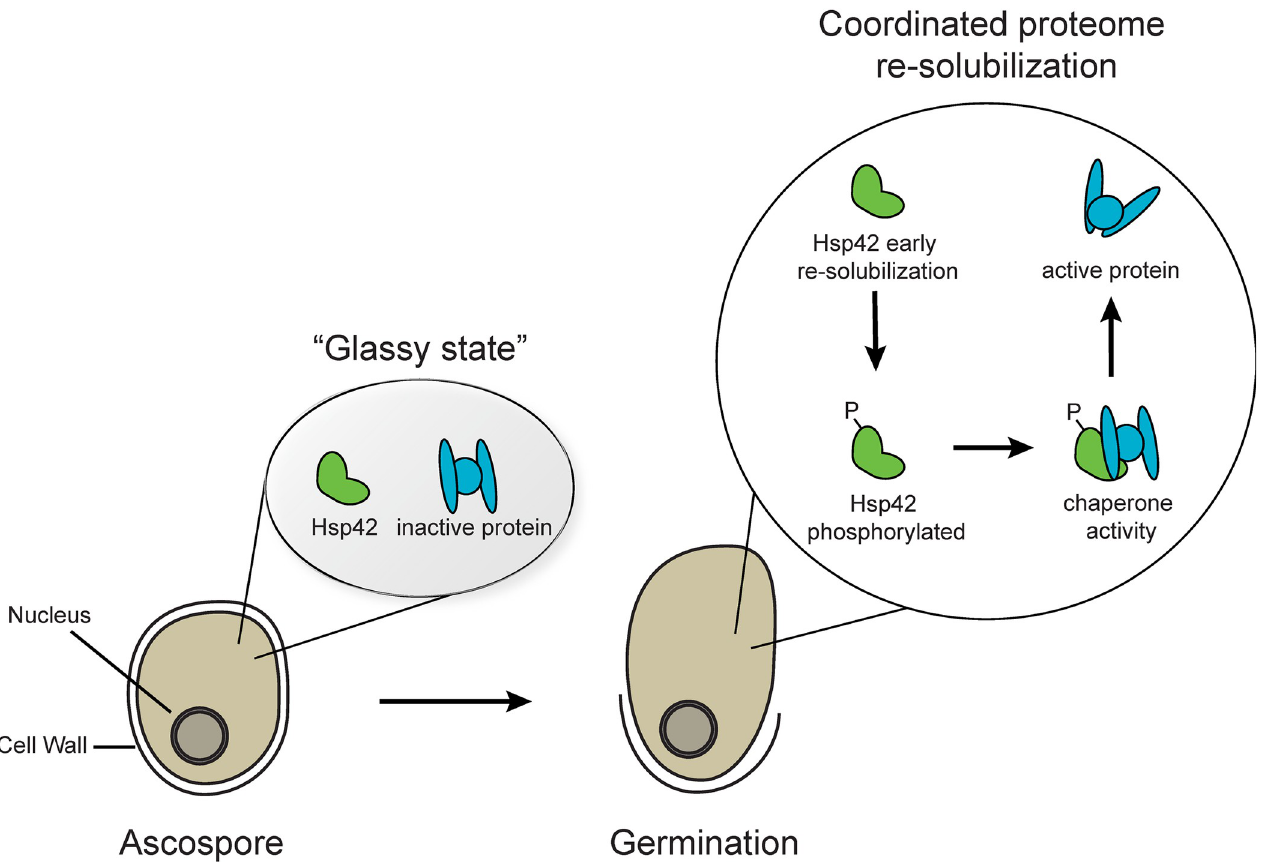
Fig 1. Protein resolubilization during germination is at least in part orchestrated by chaperone Hsp42. A cartoon visualizing protein resolubilization and the function of chaperone Hsp42 during this transition. Metabolically (nearly) inactive fungal spores contain a highly viscous cytoplasm. The highly viscous cytoplasm resembles a “glassy state” in which proteins are preserved and inactive. During germination, the viscous cytoplasm transitions to a watery cytoplasm. Some proteins resolubilize earlier than others, one such protein is chaperone Hsp42. During early stages of germination, Hsp42 gets phosphorylated and, therefore, activated and ensures proper refolding and resolubilization of the spore’s